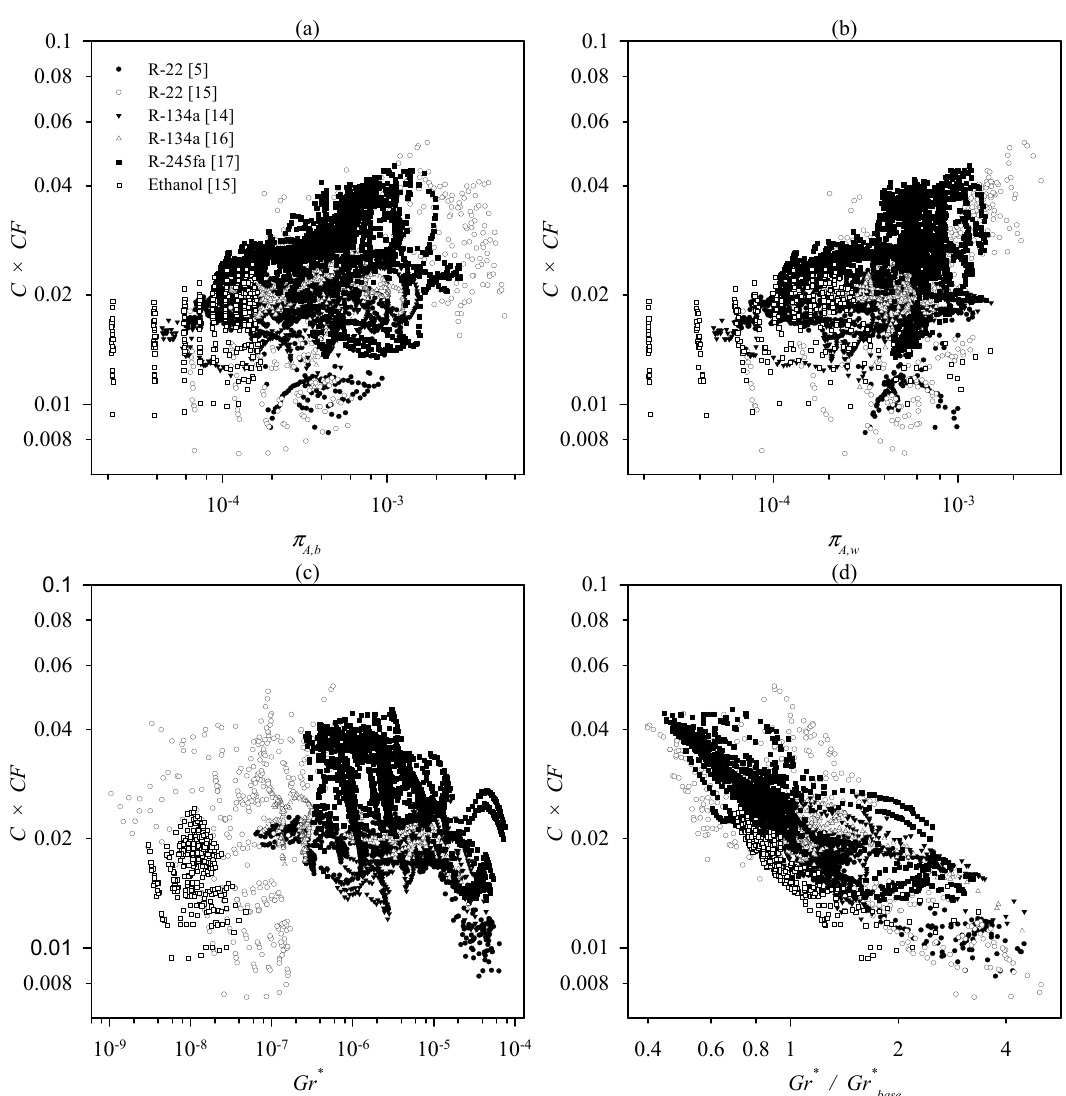
∗ , and ( d ) Gr ∗ / Gr ∗ π π . A , w , ( c ) Gr A , b , ( b ) base